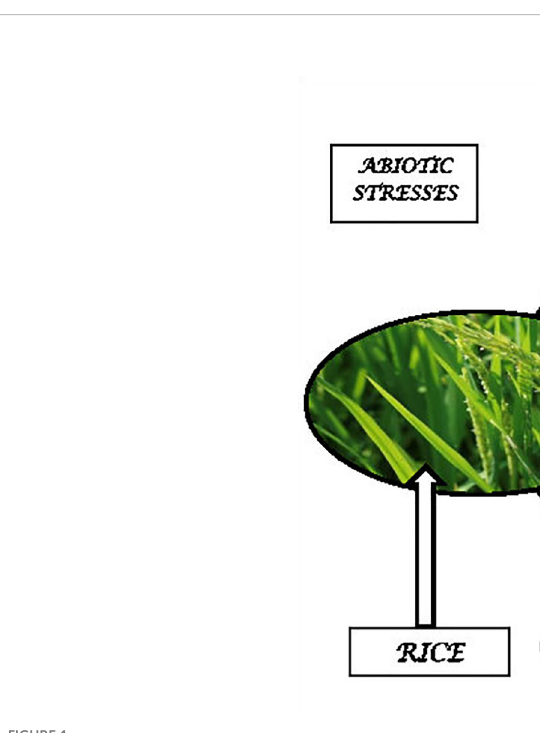
FIGURE 1 Common abiotic stresses effecting Rice